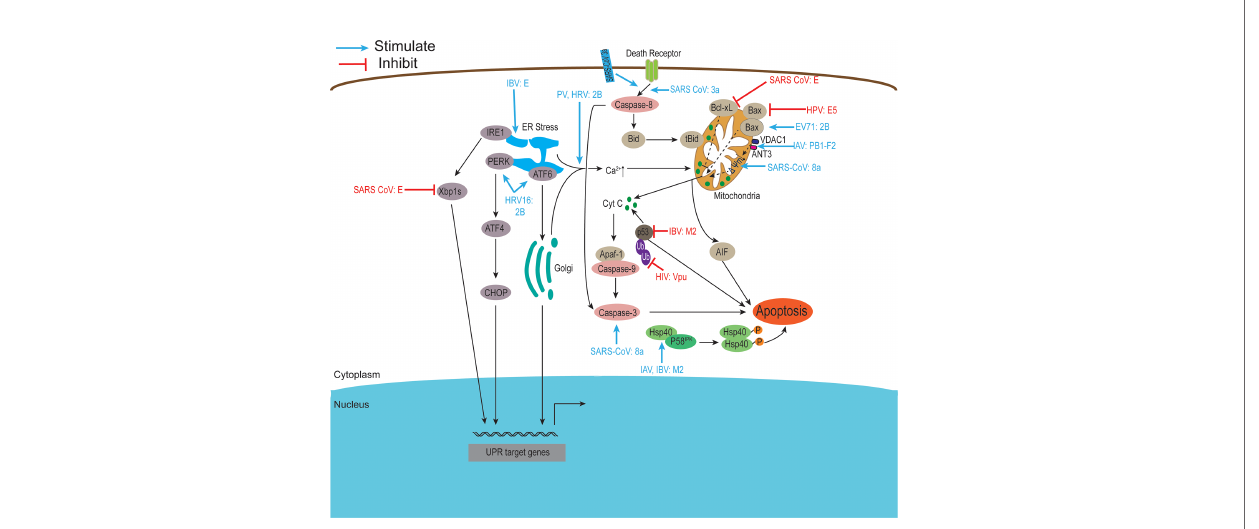
FIGURE 5 | Viroporins regulate apoptosis. Apoptosis can be activated through two major signaling pathways, the death receptor-mediated pathway, and the mitochondrial pathway. Viroporins can induce apoptosis by changing calcium ion concentration, reducing mitochondrial membrane potential, recruiting apoptosis- related factors, and activating endoplasmic reticulum stress. Some viroporins can also inhibit apoptosis. Ub, Ubiquitin. Figure adapted from